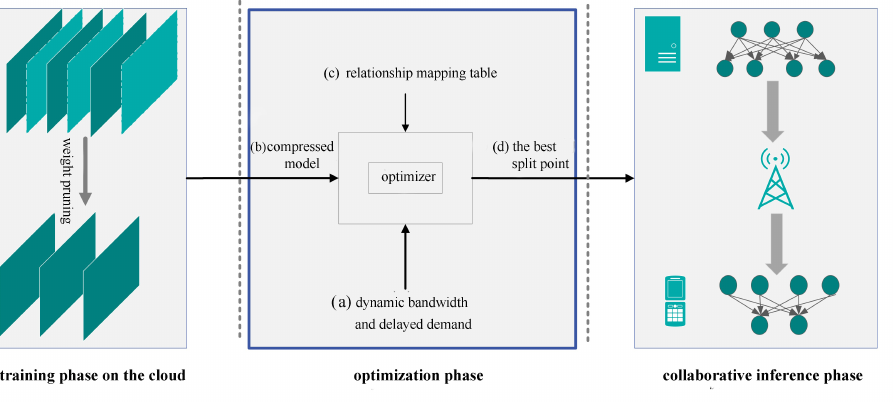
Figure 1. Overall framework of the